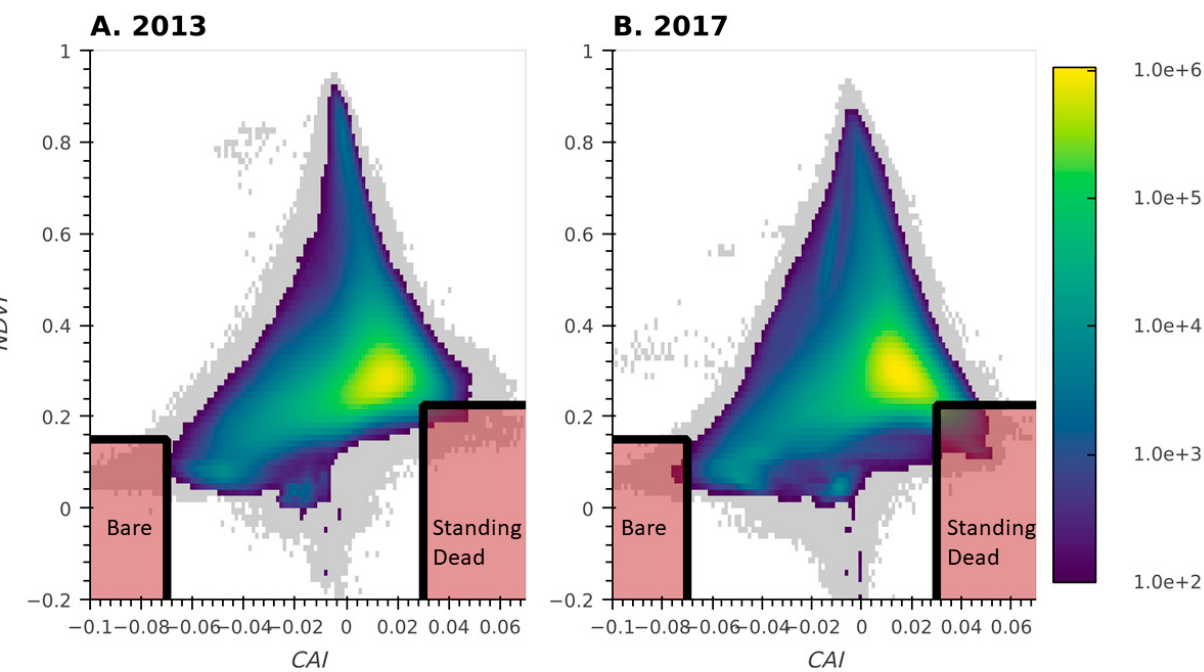
Figure 3. Two-dimensional histogram of CAI-NDVI for 2013 ( A ) and 2017 ( B ). Shaded regions indicate the space used to extract Bare Ground and Standing Dead data for the training and validation of the classification model. Grey regions represent regions with fewer than 100 pixels per